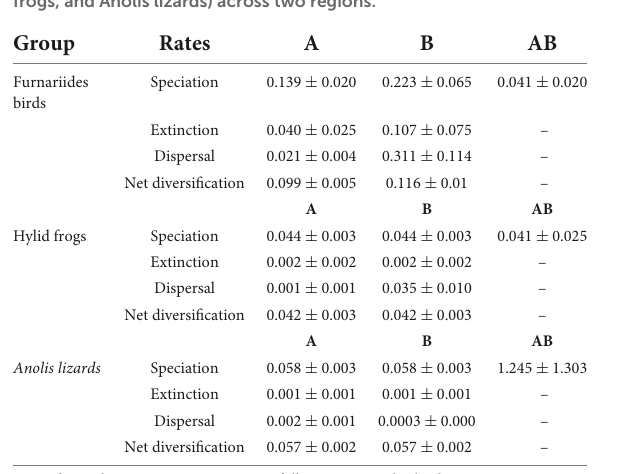
TABLE 3 Parameter estimates from the GeoSSE model for the three taxonomic groups examined in this study (Furnariides birds, hylid frogs, and Anolis lizards) across two regions.